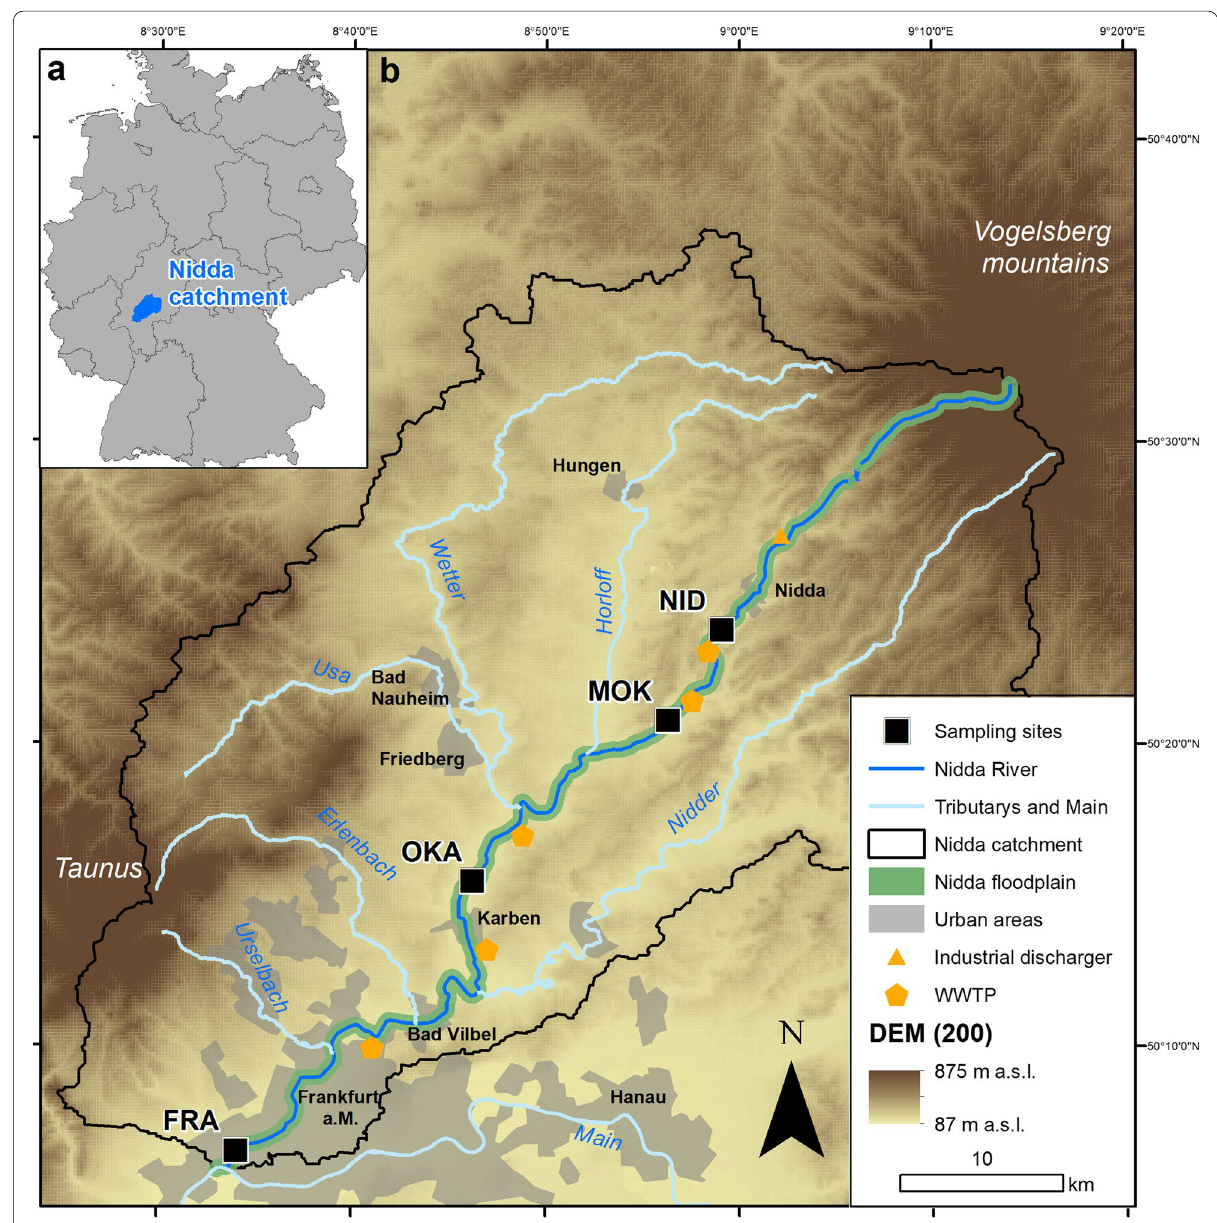
Fig. 1 a General map showing the location of the Nidda River catchment in Germany; b Nidda River catchment with tributaries, transect locations and urban areas with location of wastewater treatment plants (WWTP) and industrial dischargers along the Nidda River. Data source: NUTS 2021 (© EuroGeographics for the administrative boundaries), WISE Large rivers (© European Environmental Agency), Digital terrain model 1 (© Hessian Administration for Soil Management and Geoinformation) and urban areas (© OpenStreetMap contributors 2021. Distributed under the Open Data Commons Open Database License (ODbL) v1.0.). Detailed maps of transect sites and elevation profiles can be found in Fig.